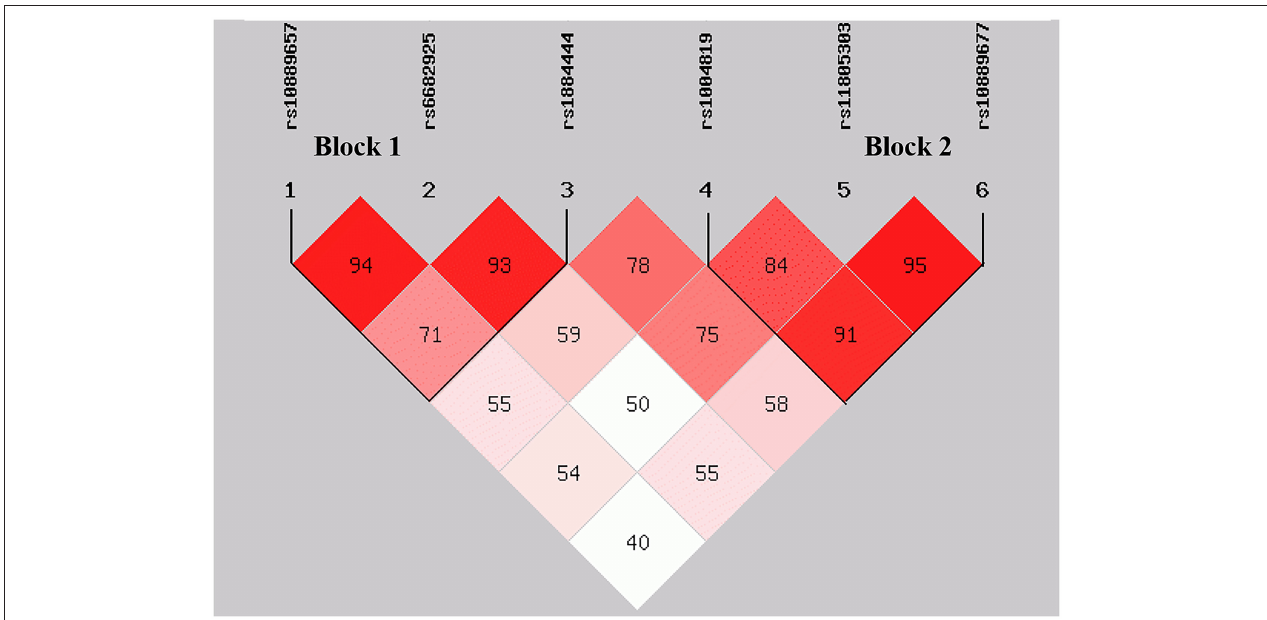
FIGURE 2 | Distribution of blocks defined by linkage disequilibrium scores of six SNPs in IL-23R . The data indicate D ′